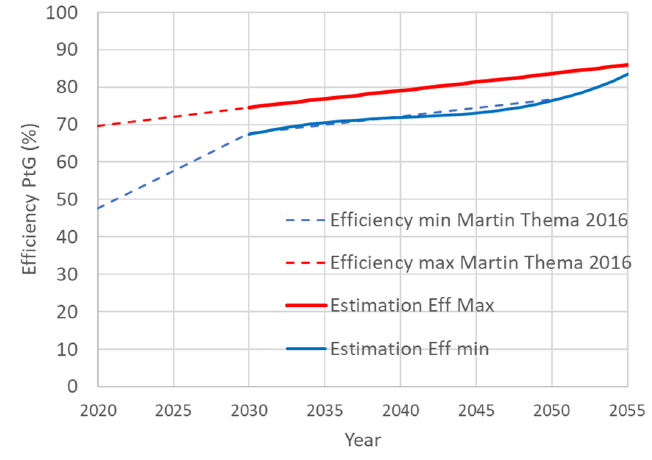
Figure 5. Efficiency range vs. time of the transformation from electricity to gas.